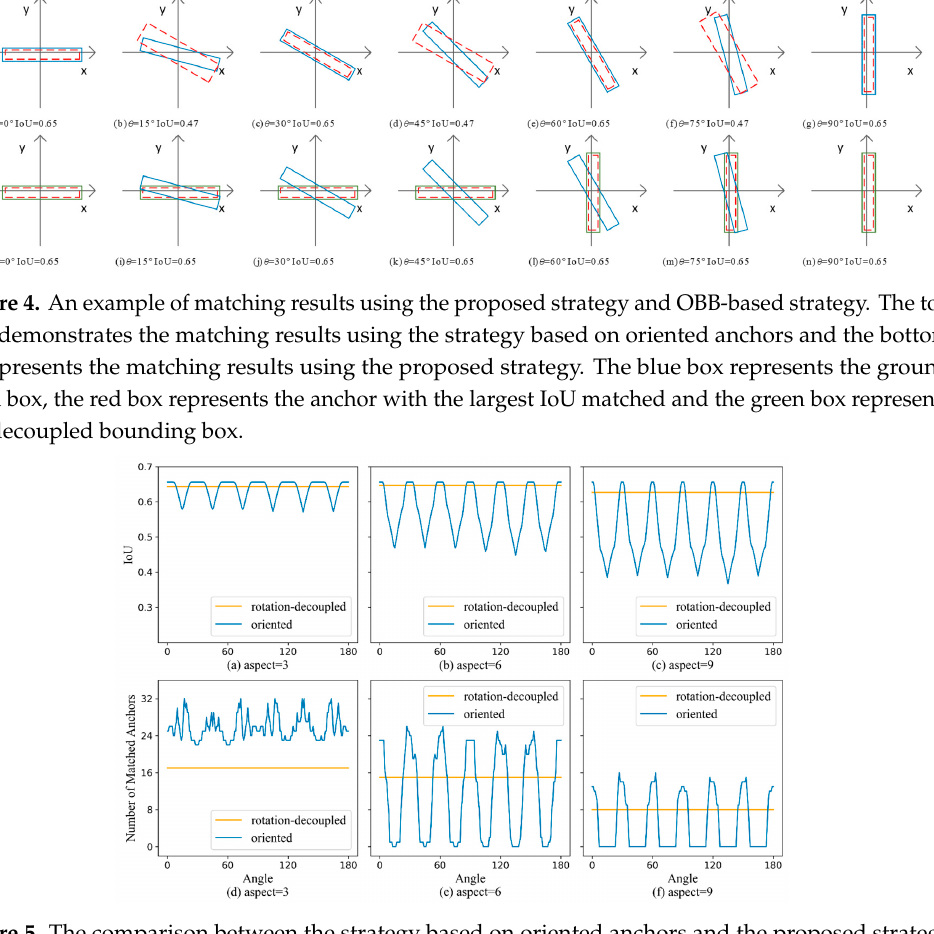
Figure 5. The comparison between the strategy based on oriented anchors and the proposed strategy. The top row shows the change in the maximum IoU with the angular change. The bottom row shows the change in the number of matched anchors with angular change.